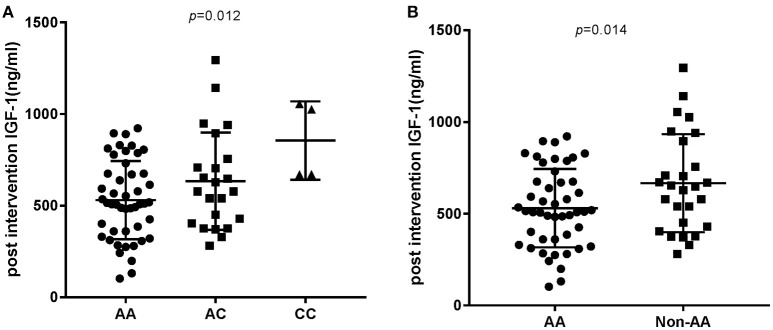
Post intervention IGF-1 level according to the IGFBP3 genotype. (A) Post intervention IGF-1 level according to AA/AC/CC genotypes. P-value for comparison among the three groups was p = 0.012. (B)
P-value for comparison between the AA and Non-AA genotypes was 0.014.